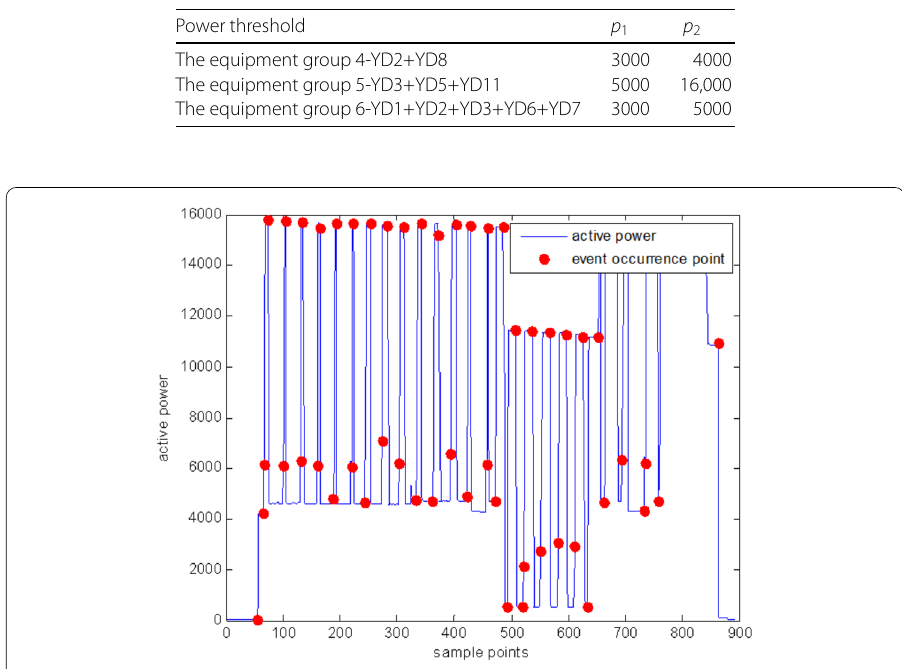
Figure 1 Event detection diagram for equipment group